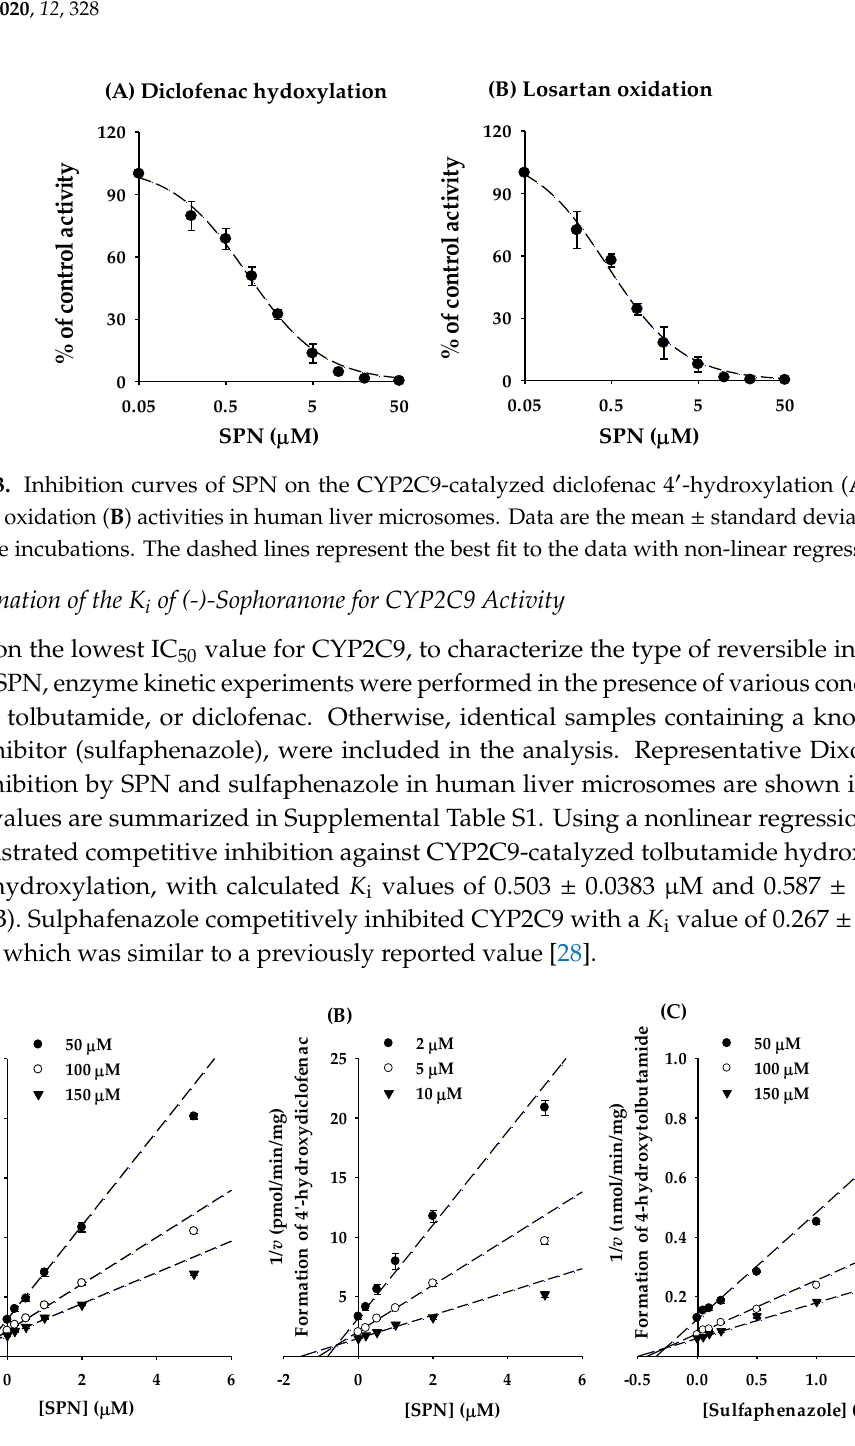
Figure 4. Dixon plots to determine K i values of SPN on the CYP2C9 enzyme activity, using tolbutamide ( A ) or diclofenac ( B ) as substrates. The well-known inhibitor of CYP2C9, sulfaphenazole, is used as a positive control ( C ) using tolbutamide as a substrate. The concentrations of tolbutamide were determined 50 (●), 100 ( ○ ), and 150 ( ▼ ) μM, respectively; diclofenac was used at 2 (●), 5 ( ○ ), and 10 ( ▼ ) μ M, respectively. v represents formation rate of 4-hydroxytolbutamide (nmol/min/mg protein) or 4 ′ -hydroxydiclofenac (pmol/min/mg protein). Data are the mean ± standard deviation of triplicate incubations. The dashed lines of SPN ( A,B ) and sulfaphenazole ( C ) all fit well to competitive inhibition types.